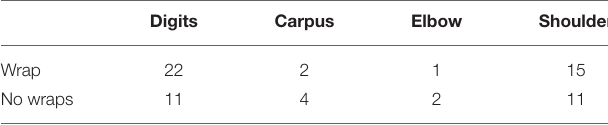
TABLE 5 | Forelimb injury categorization (digit, carpus, elbow shoulder) and Fisher’s Exact Test–no p -value was below p < 0.18.